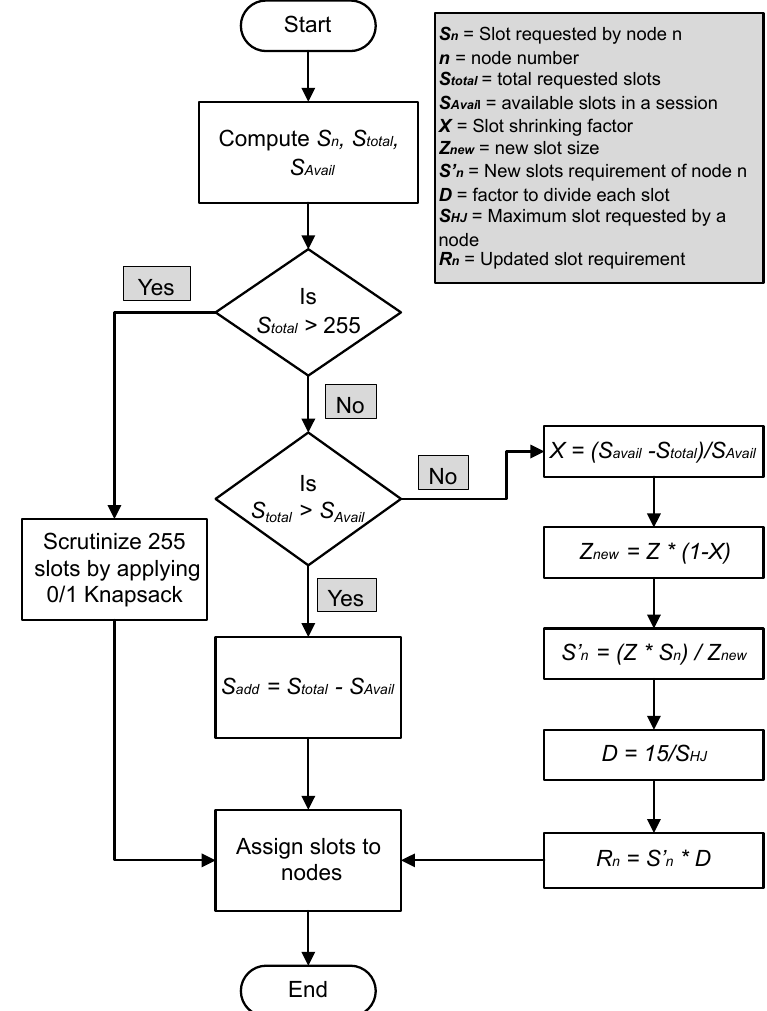
Figure 4. Proposed algorithm for adaptive data requirements in vehicular